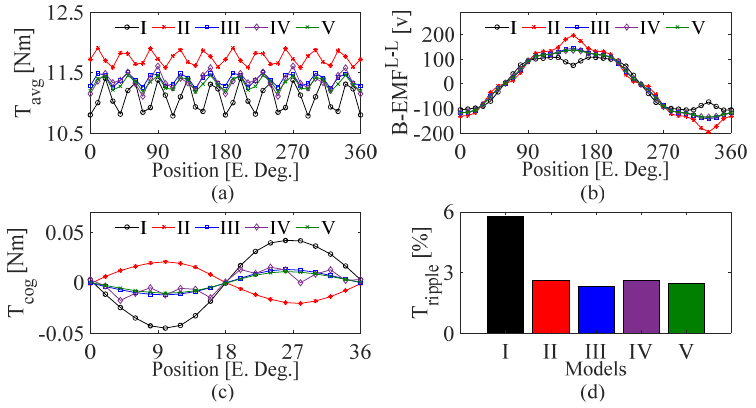
Figure 7. FEA results at rated current: ( a ) Average Torque, ( b ) L-L Back-EMF, ( c ) Cogging Torque and ( d ) Torque Ripple.